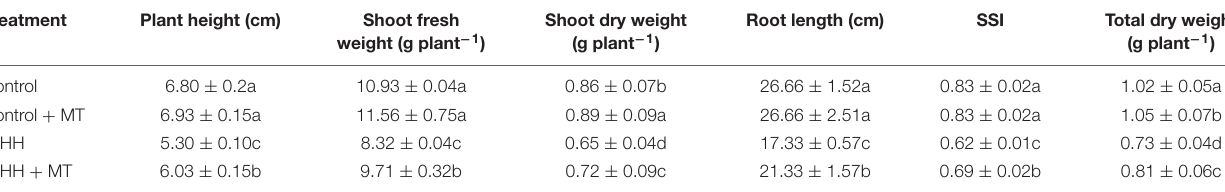
TABLE 1 | Effect of melatonin on cucumber seedling morphology under low-temperature and high-humidity